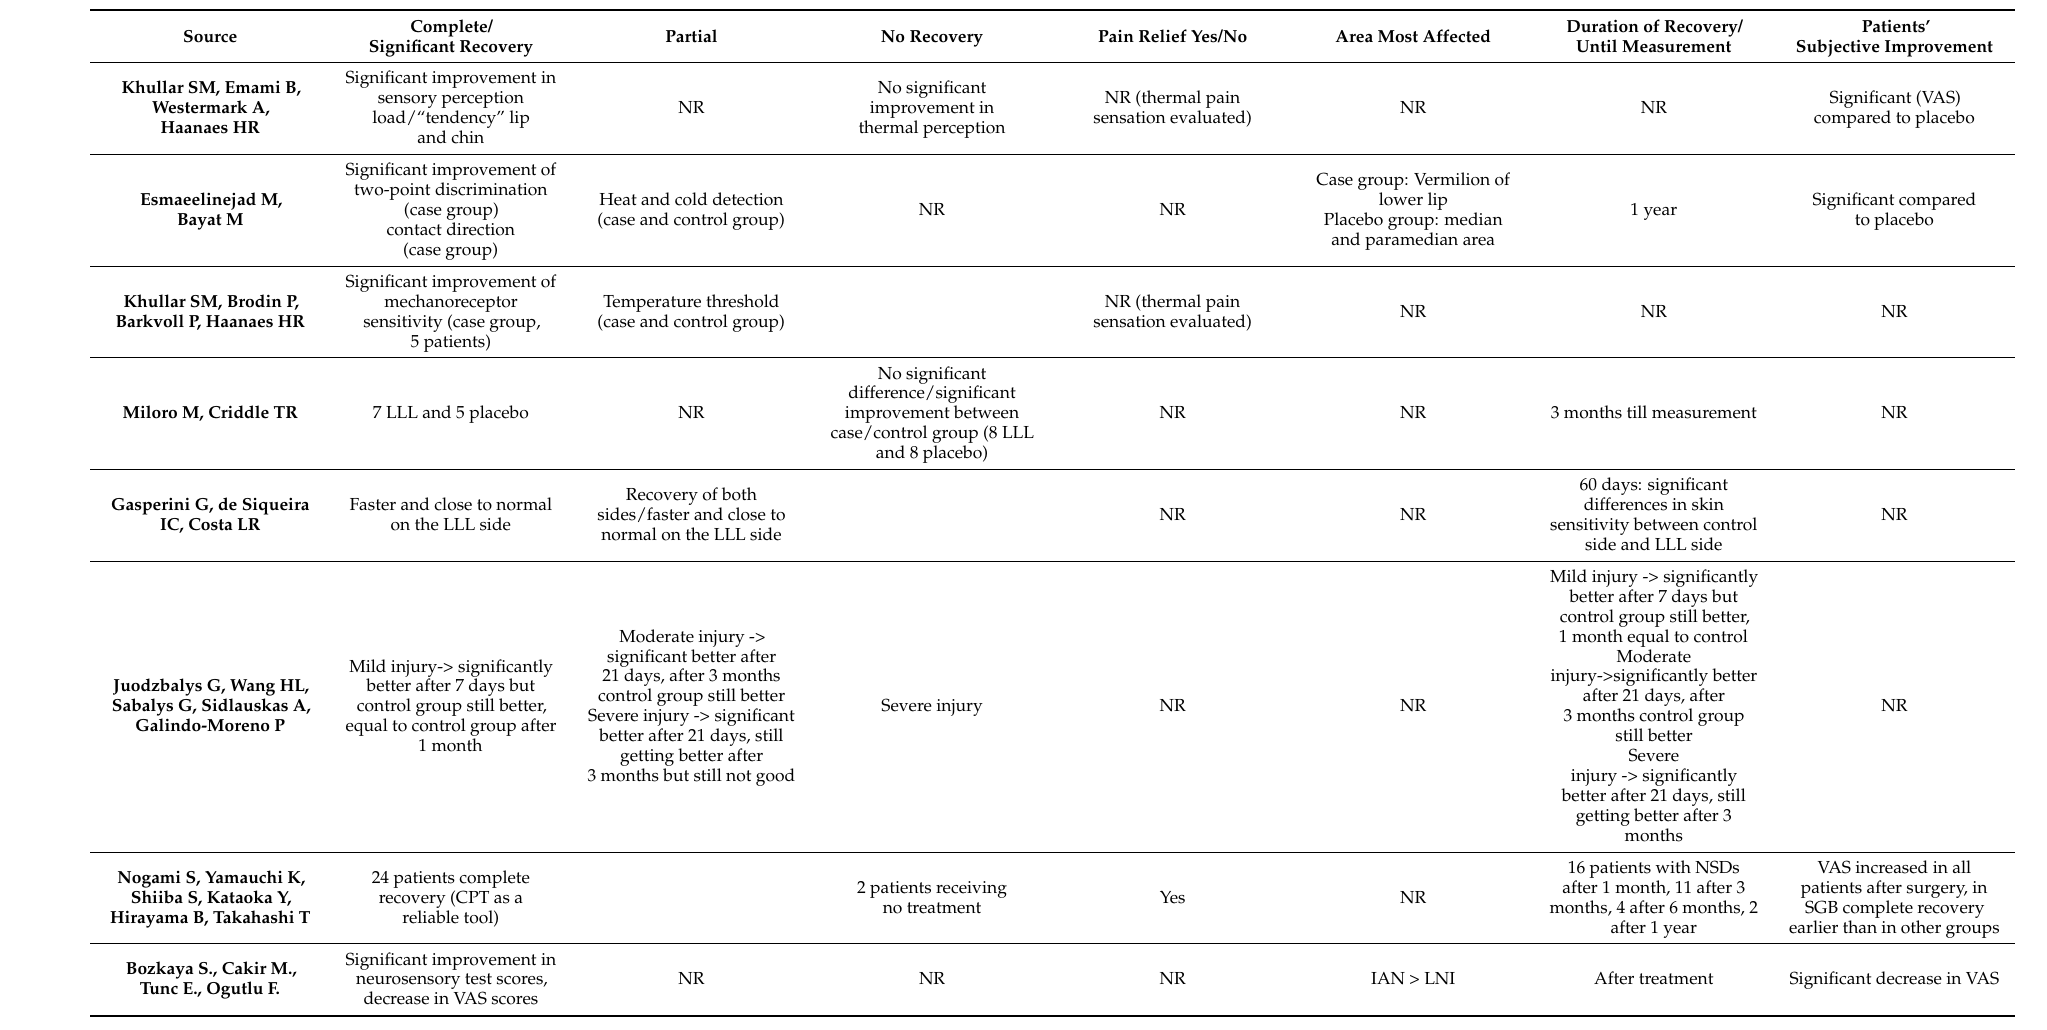
Table 5. Outcome of neurophysiological